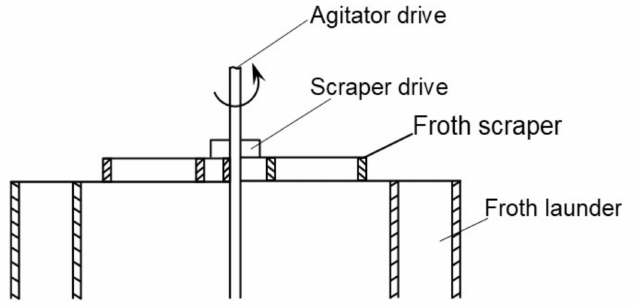
Figure 11. Cross-section of a circular flotation cell showing a full surface froth scraper